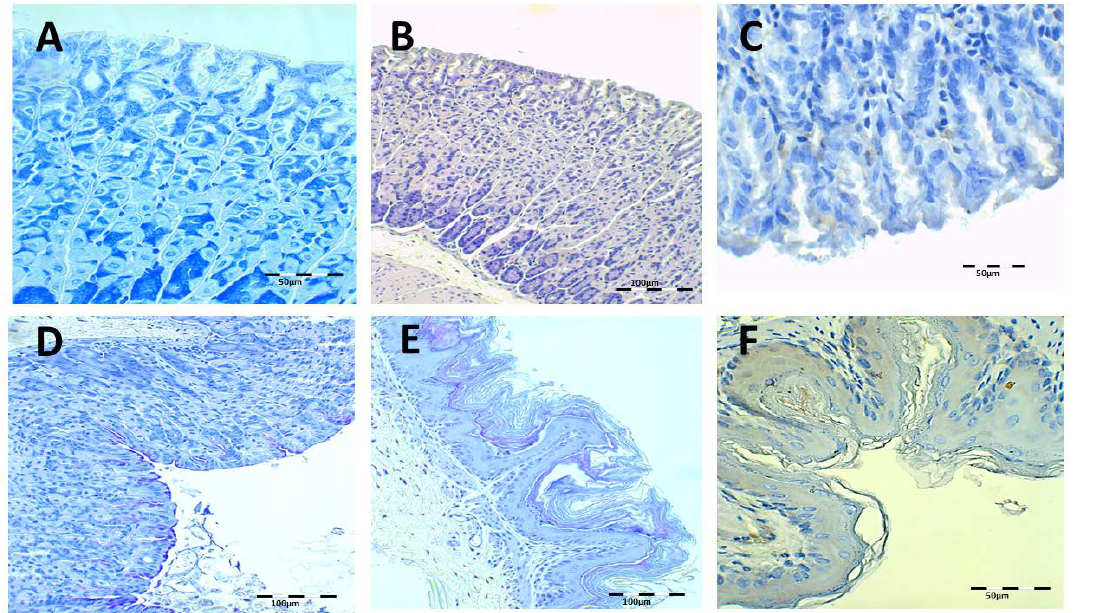
Figure 8. Healthy control animal microphotographs of the stomach ( A – D ) and esophagus ( E , F ), stained with Giemsa ( A ), hematoxylin/eosin staining (H–E) ( B , E ), immunohistochemistry (IHC) ( C , F ), and Periodic Acid-Schiff (PAS) ( D